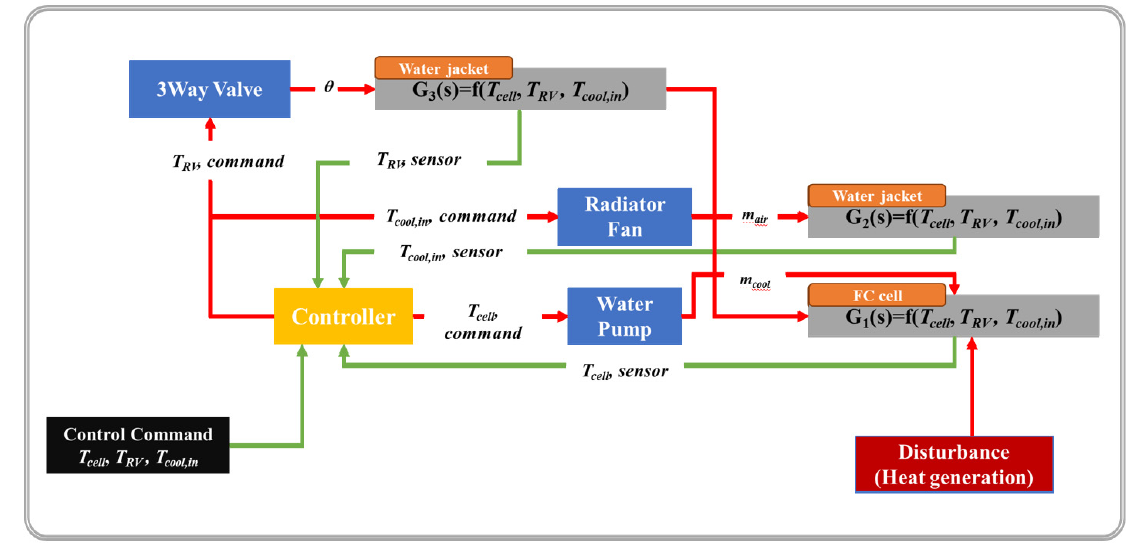
Figure 1. Schematic of PI control response for cooling system.